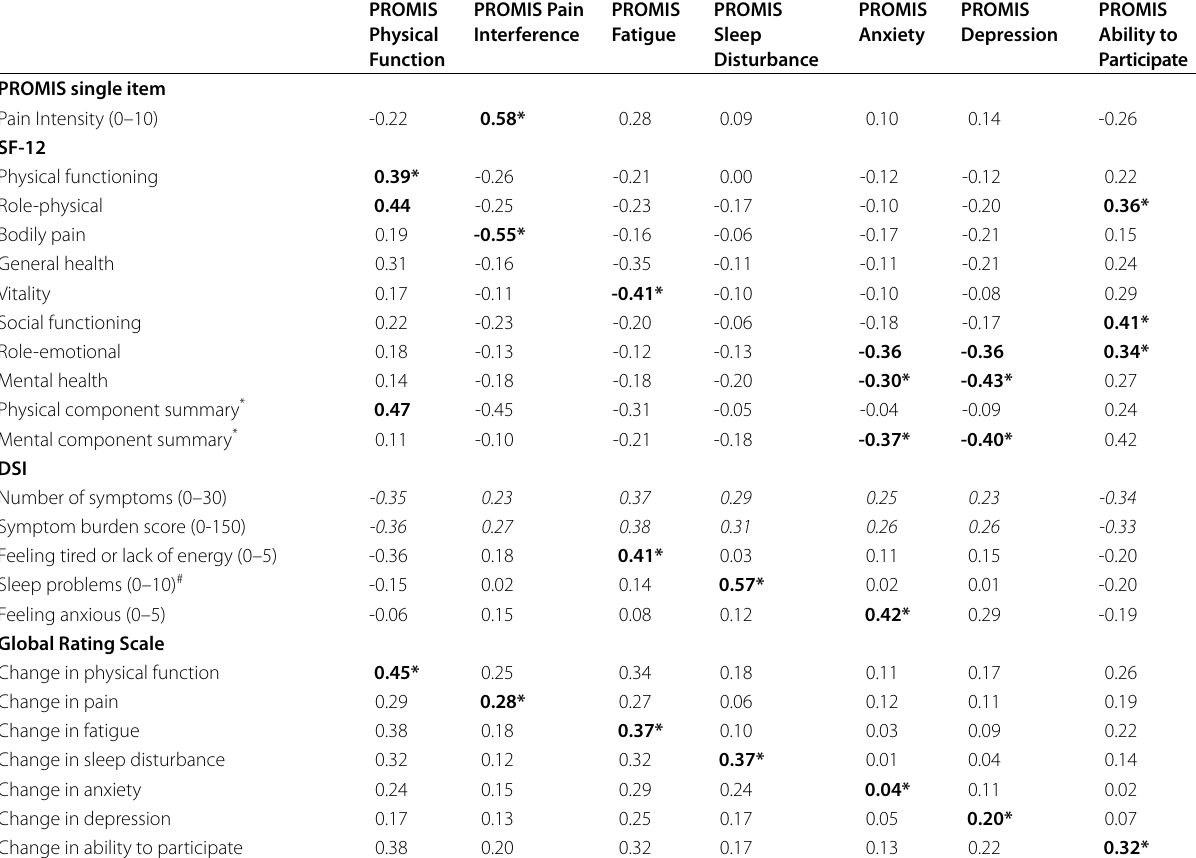
Table 1 Expected and observed correlations between PROMIS CAT change scores and change scores in SF-12 and